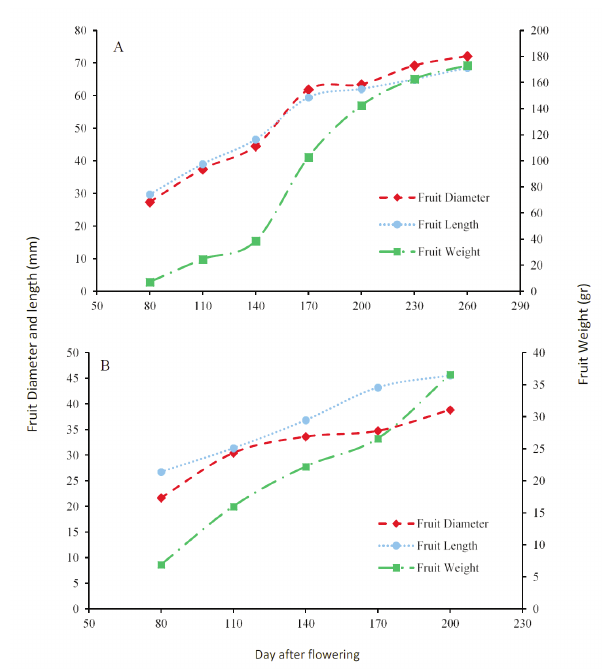
Fig. 1 ­ Fruit growth curve based on fruit weight, diameter and length of sour orange (A) and Mexican lime (B).